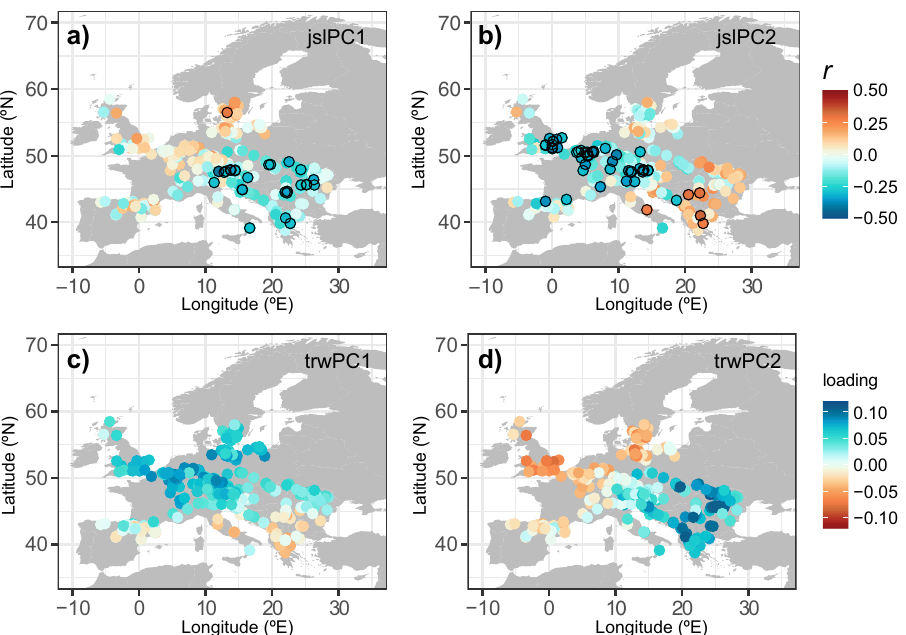
Fig. 3 Spatial patterns of radial tree growth in relation to summer JSL variability. Correlation map of European beech chronologies and the scores of jslPC1 ( a ) and jslPC2 ( b ). The bottom panels show the spatial pattern of loadings for the fi rst ( c ) and second mode ( d ) of radial tree growth variability (trwPC1 and trwPC2). Black circles in the upper panel indicate signi fi cant correlations ( p < 0.05). Analyses were performed for the period 1950 – 2005.